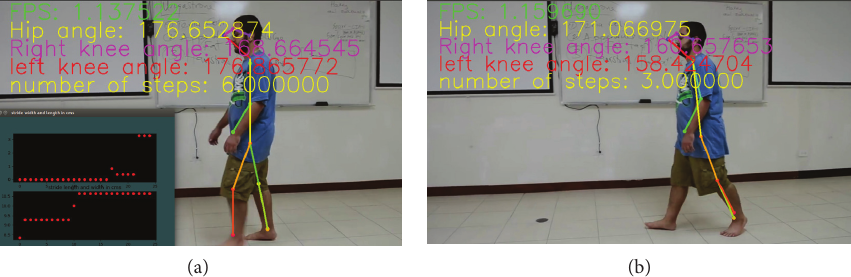
Figure 9: Real-time results with different environment setups (a, b), lighting conditions, angles (side), camera distance: ∼ 2.5 m from the subject.